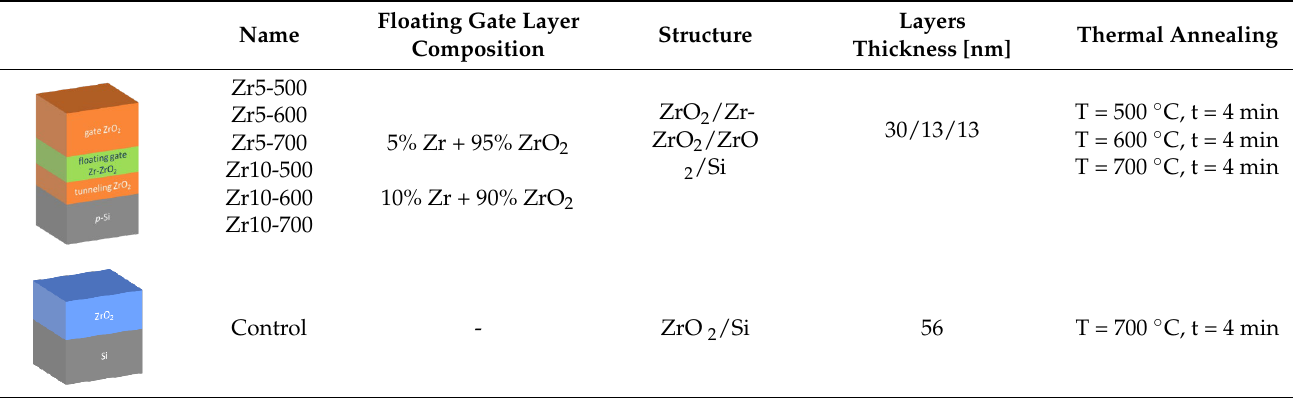
Table 1. Structure configuration and preparation details of the trilayer ZrO 2 [gate oxide]/Zr–ZrO 2 [floating gate]/ZrO 2 [tunneling oxide]/p-Si and the control structure.